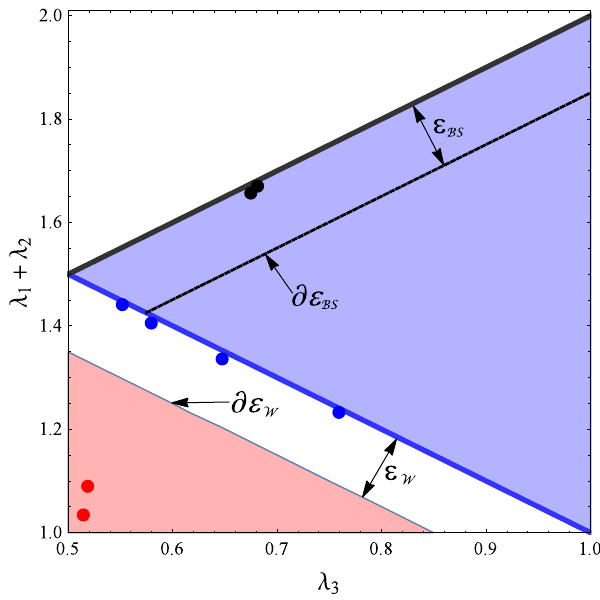
FIG. 4. Projected eigenvalue space. The red region represents the GHZ polytope, and the blue region the W polytope. The black line represents the BS polytopes. The vertical axis contains a sum of two eigenvalues. For the case of the BS states, it always contain the maximum eigenvalue, which is close to 1, in such a way that all three classes of BS states are projected onto the same line. As in Fig. 3, the blue dots are the W states while the red and black ones represent the GHZ and BS states, respectively. The white region between the GHZ and W polytopes (whose theoretical border ∂ W was obtained considering pure states) is the error region ε W , which is a function of the purity of the experimental density matrix (see Appendix C for details). The border for mixed states is represented by ∂ ε W . The same pattern is applied to the border between the B S and W polytopes (dashed line). To compute the size of this region, we choose the lowest purity among all the prepared